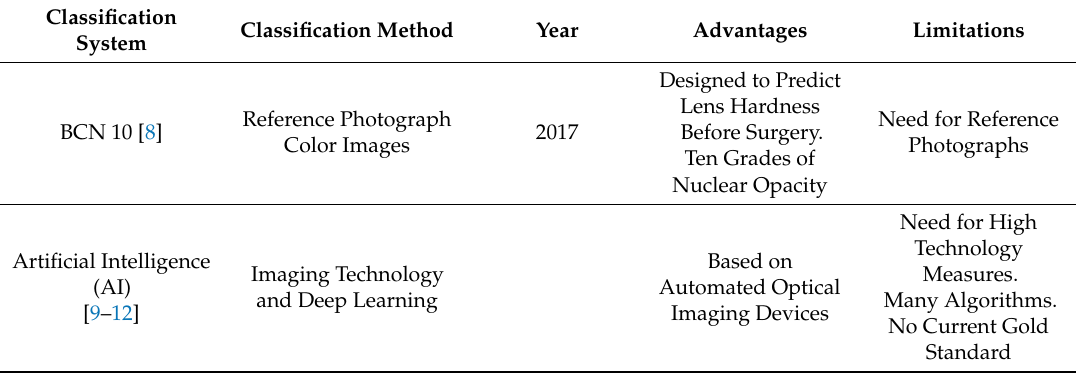
Table 2. Current cataract classification system.